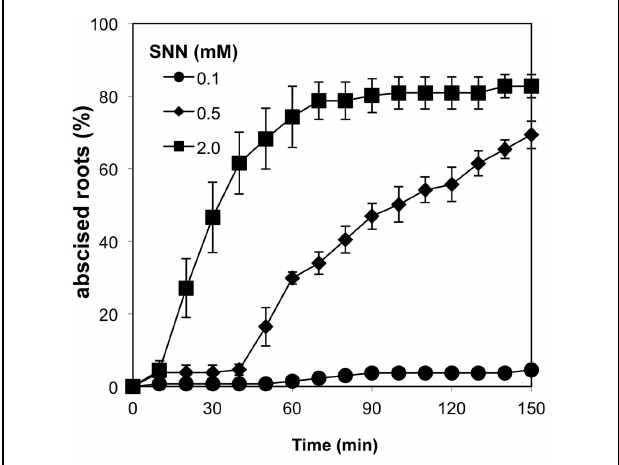
FIGURE 4 | Dose-dependent induction of A. pinnata root abscission by spermine NONOate (SNN). 0.1 mM ( n = 3), 0.5 mM ( n = 4), 2.0 mM ( n = 4; means ±